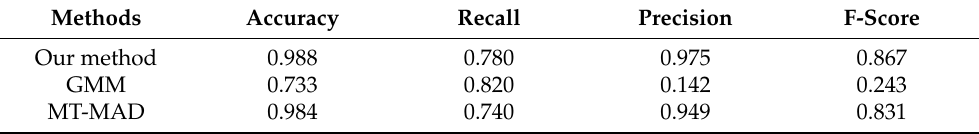
Table 2. Effectiveness of our method in abnormal behavior detection for ship spatial attributes.